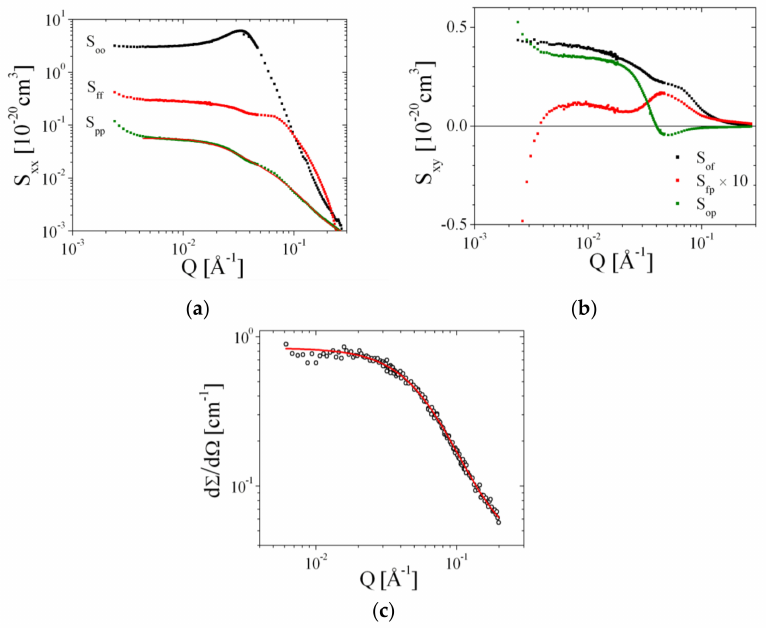
Figure 9. The deconvoluted scattering functions of the Comb 4 polymer in the microemulsion ( a , b ) and the polymer scattering in a good solvent (deuterated THF) ( c ). The polymer scattering is, in both cases, modeled as discussed in the main